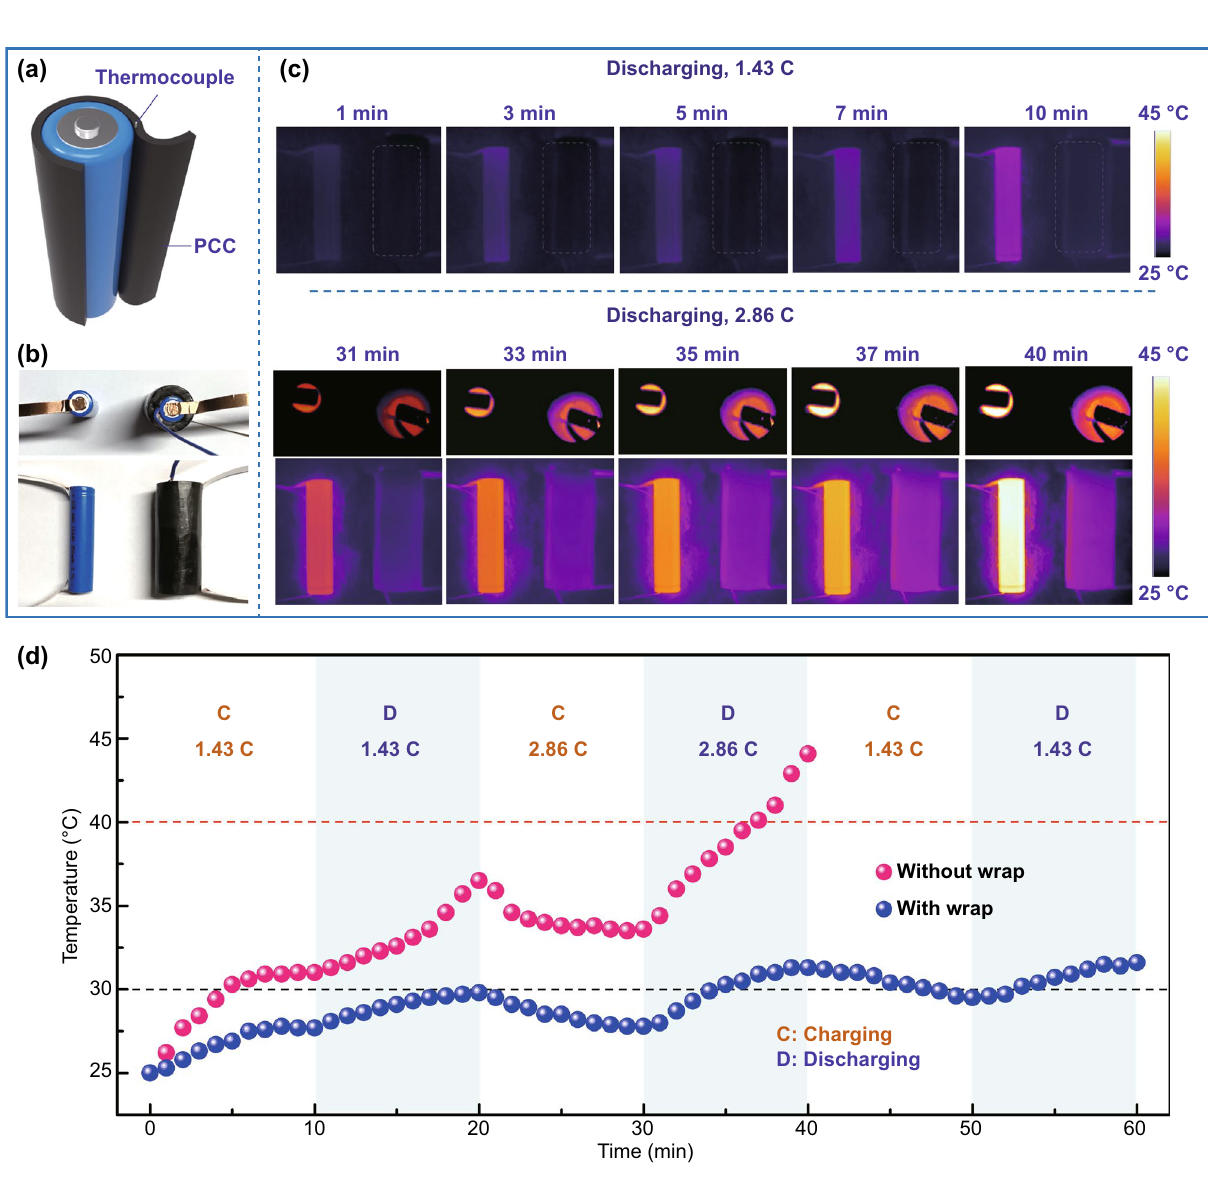
Fig. 6 a Illustration of integration components for lithium‑ion battery with PCC wrap. b Optical photographs of lithium‑ion battery with/with‑ out PCC wrap in a circuit. c Infrared thermographs of lithium‑ion battery with/without wrap during discharge at the rate of 1.43 C and 2.86 C. d Surface temperature variation curves of lithium‑ion battery with/without wrap during charging and